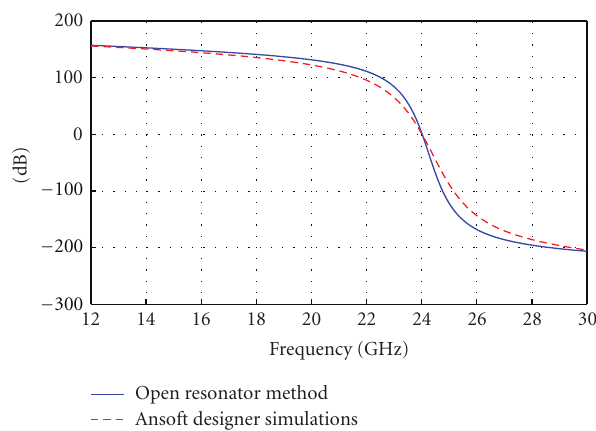
Figure 13: Reflection phase versus frequency for the case L = 3 . 5mm.